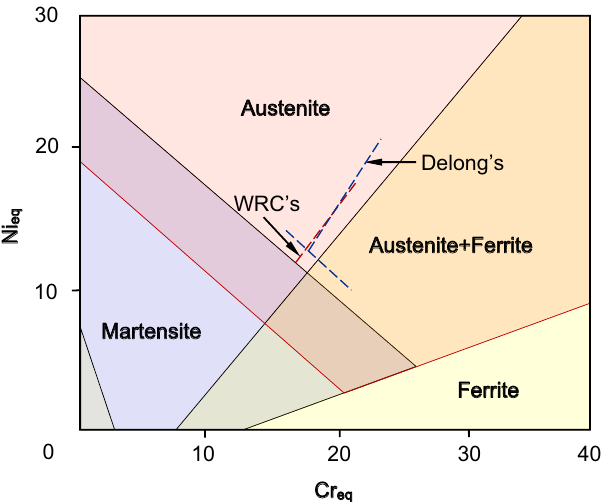
Figure 1. Original Schaeffler constitution diagram 1 , showing modified boundaries of austenite zone and its overlapped zones with ferrite and martensite by Delong 2 (dashed blue lines) and WRC 8 (dashed red line).